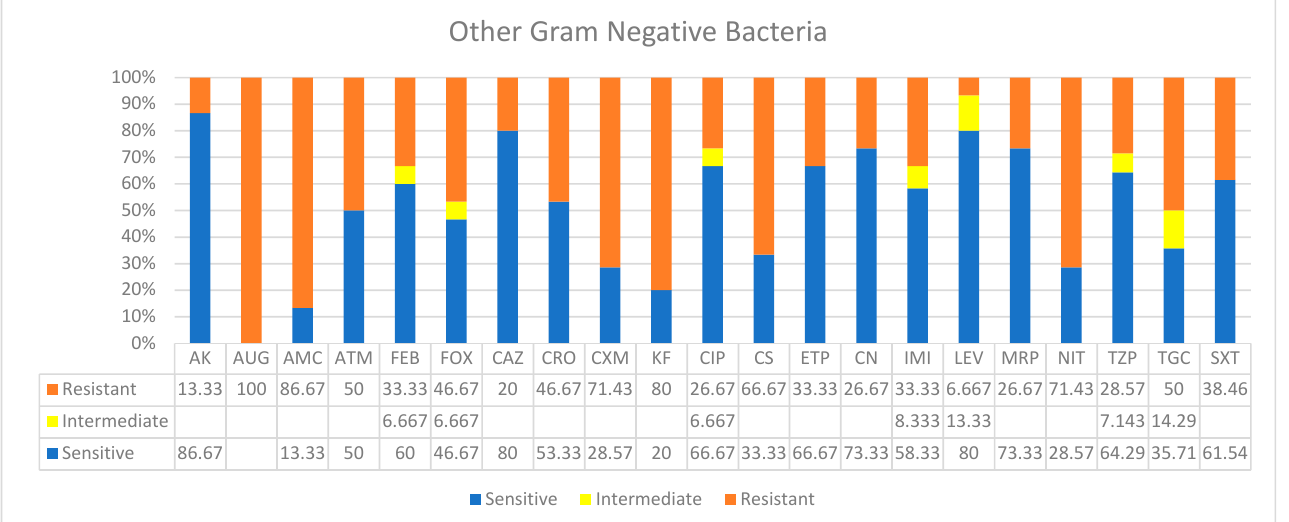
Figure 5. Antimicrobial sensitivity patterns of “other” Gram-negative bacterial clinical isolates against 21 antibiotics.